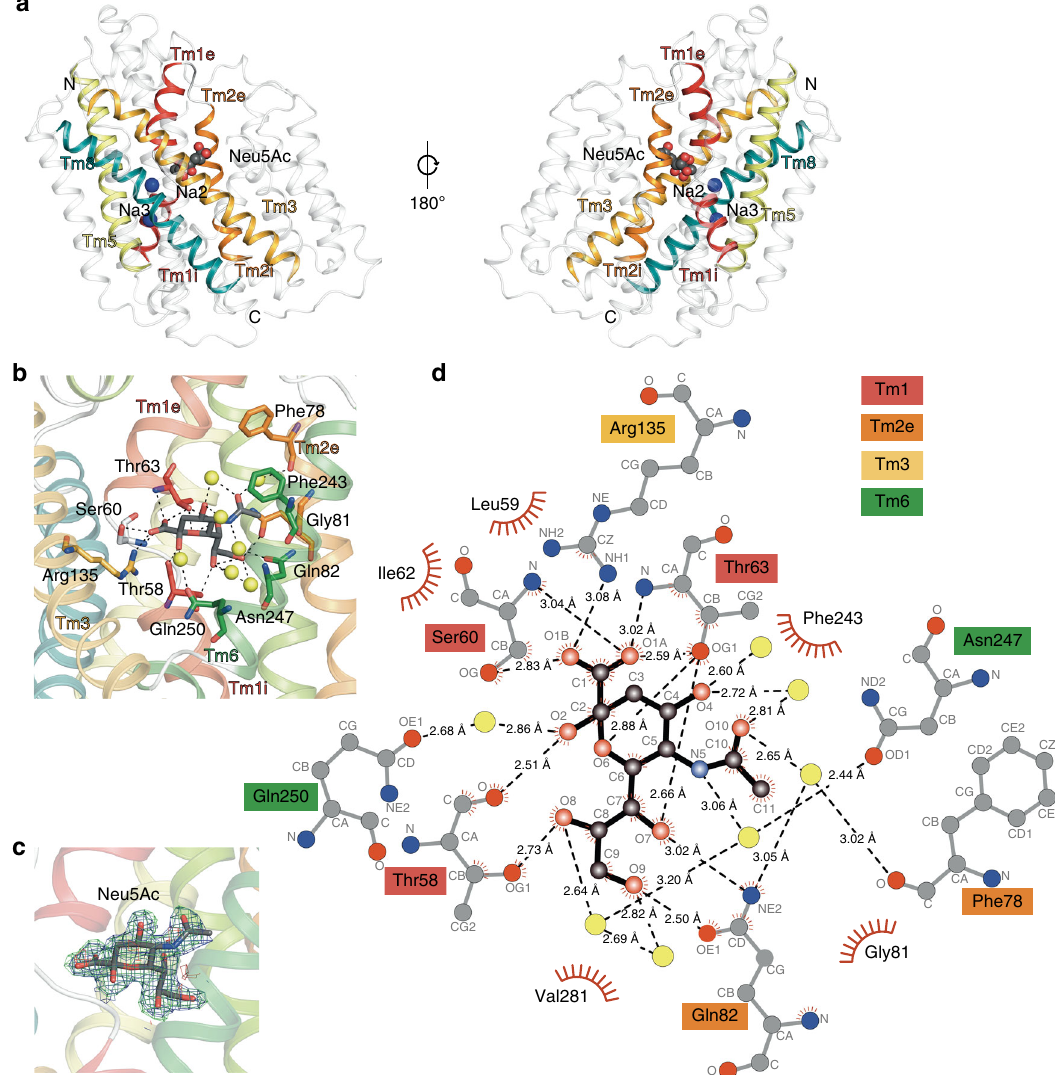
Fig. 1 Overall architecture and the sialic acid binding site of SiaT. a Side-view of SiaT in the membrane plane. Transmembrane helices that coordinate with Neu5Ac and Na + ions are depicted in colour, while the remaining helices are coloured in white. Neu5Ac is shown as grey spheres coloured by atom type and Na + ions are shown as blue spheres. b Neu5Ac forms hydrogen bonds with Thr58 (Tm1), Thr63 (Tm1), Ser60 (Tm1) and Gln82 (Tm2) and a salt bridge with Arg135 (Tm3). Neu5Ac also forms water-mediated hydrogen bonds with Gln82 (Tm2), Asn247 (Tm6), Gln250 (Tm6) and Phe78 (Tm2). c Omit maps for Neu5Ac generated by removing respective ligands from the X-ray structure followed by re fi nement. The 2 F o − F c electron density map is contoured at l σ (blue), the F o − F c map is contoured at 3 σ (green) and − 3 σ (red). d The SiaT – Neu5Ac interaction network represented as a Ligplot + diagram. Hydrogen bonds (dashed lines), hydrophobic contacts (arcs with spokes) and interacting water molecules (yellow) are